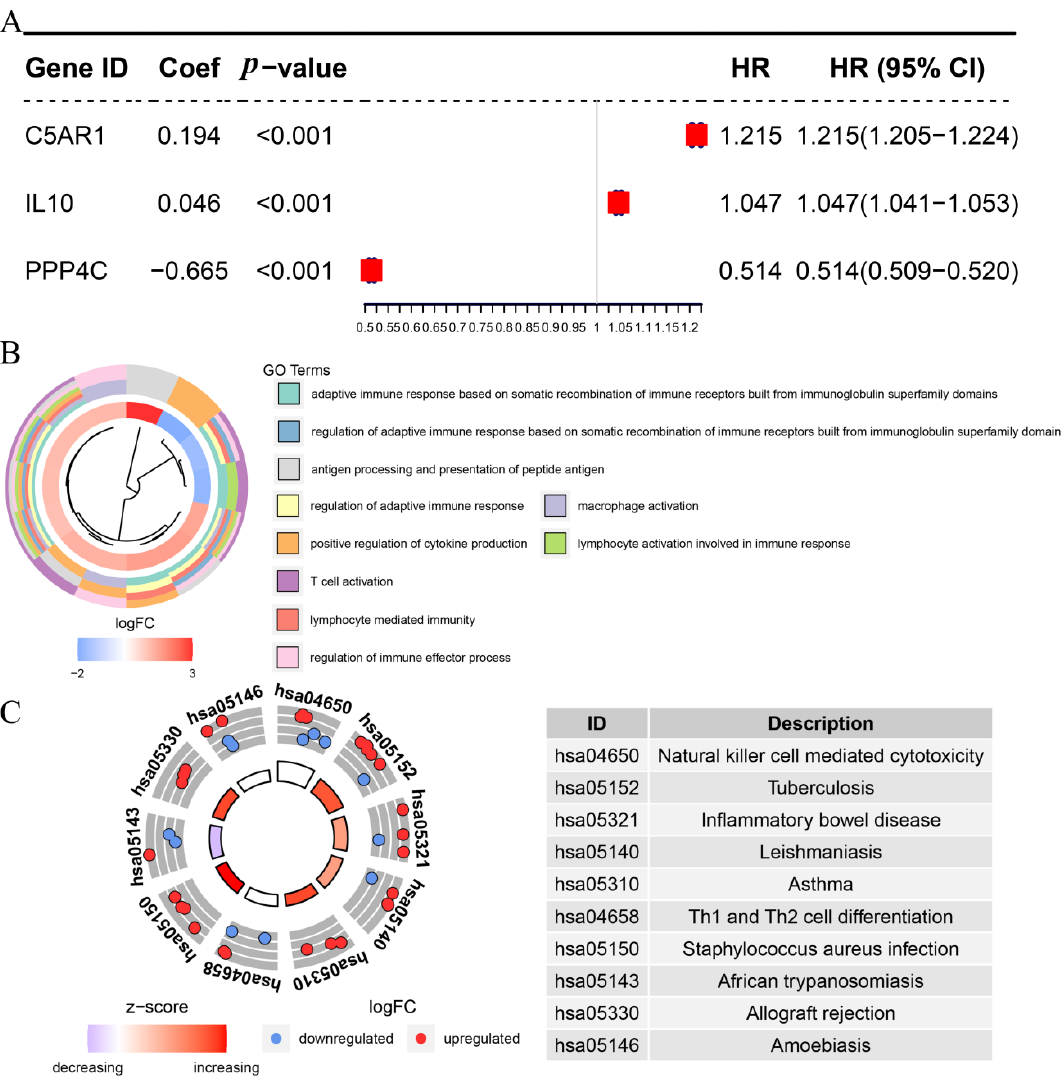
Figure 5. ( A ) Multivariate Cox analysis of three hub IRGs; ( B ) GO enrichment terms for hub IRGs. The inner ring is a bar plot where the color of the bar indicates the logFC of the term. The colors in the outer ring indicates the description of GO terms; ( C ) KEGG circle plot for IRGs. The inner ring is a bar plot where the height of the bar indicates the significance of the term. Red dots in the outer ring indicate upregulated genes and blue dots indicate downregulated genes.